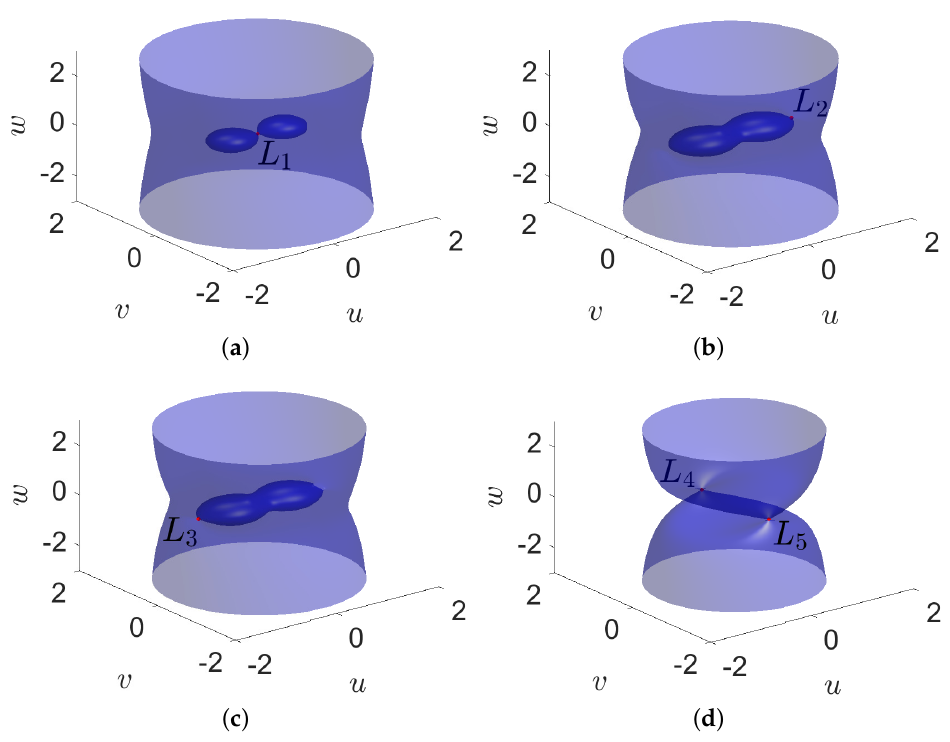
Figure 2. Zero-velocity surfaces of the third body for κ = 1: ( a ) C = 4.16993, ( b ) C = 3.59308, ( c ) C = 3.57940, ( d ) C =